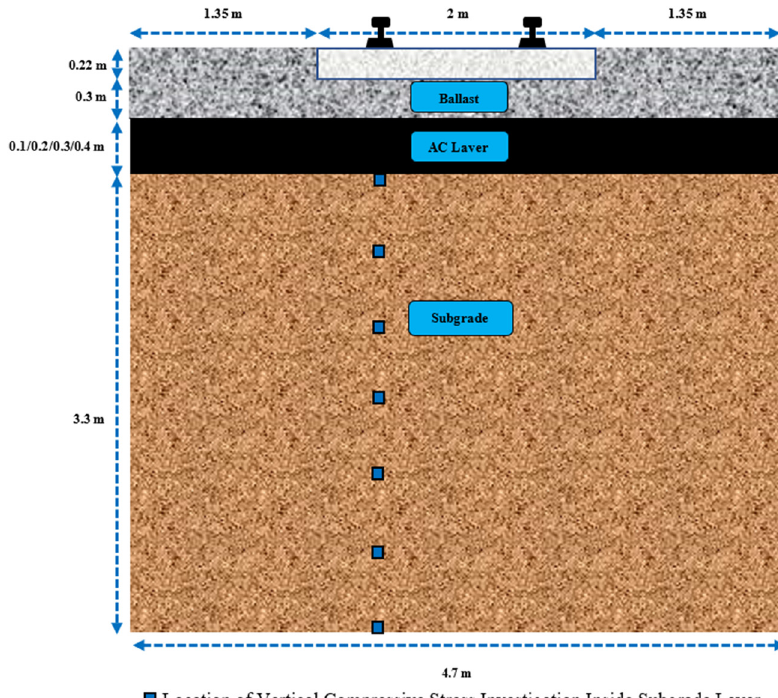
Figure 2: Asphaltic underlayment track geometric for numerical modeling.